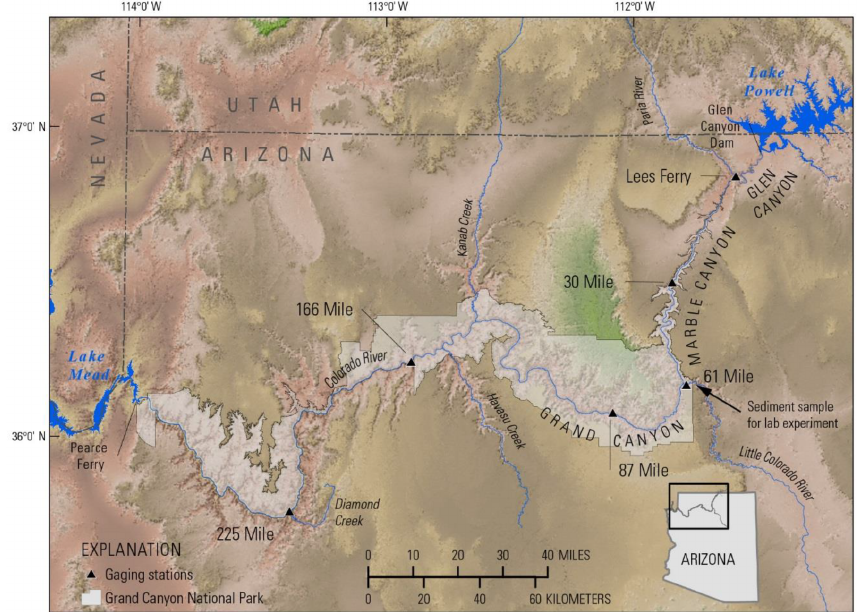
Figure 3. Map of northwestern Arizona, showing the study area in Grand Canyon, major tributaries, and the location of the gaging stations. Gaging stations at which turbidity, suspended sediment and other water-quality data were collected are as follows: Colorado River at Lees Ferry, AZ, 09380000 (abbreviated as Lees Ferry); Colorado River near river mile 30, 09383050 (abbreviated as 30 Mile); Colorado River above Little Colorado River near Desert View, AZ, 09383100 (abbreviated as 61 Mile); Colorado River near Grand Canyon, AZ, 09402500 (abbreviated as 87 Mile); Colorado River above National Canyon near Supai, AZ, 09404120 (abbreviated as 166 Mile); and Colorado River above Diamond Creek near Peach Springs, AZ, 09404200 (abbreviated as 225